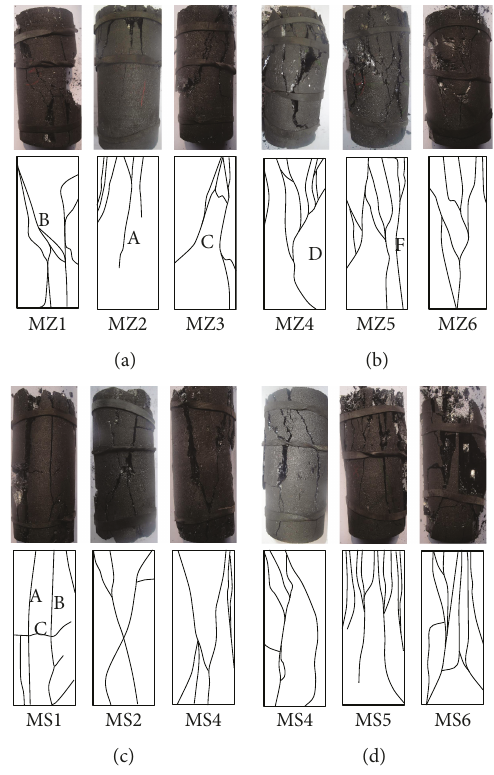
Figure 9: Failure modes of coal samples for the uniaxial compression and step loading